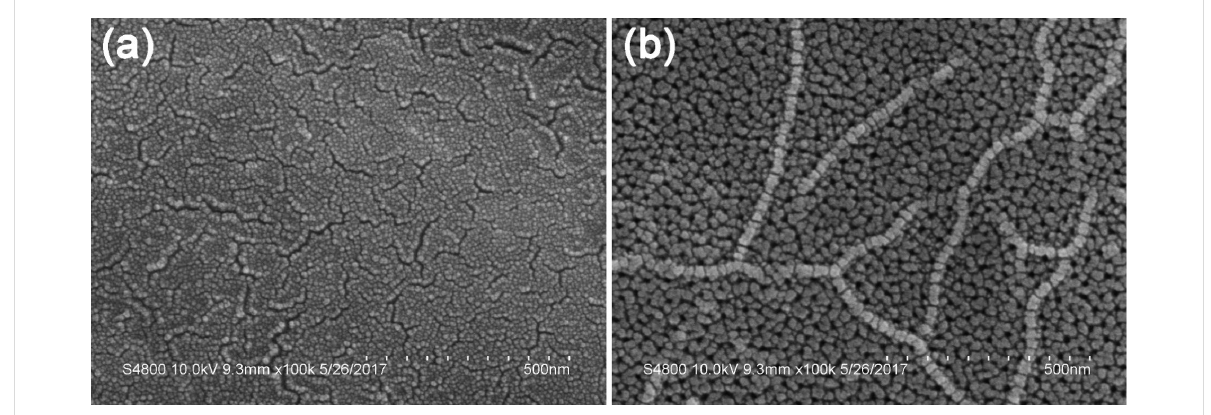
Figure 1: a,b) SEM images of the surface of the aluminum alloy before (a) and after (b)